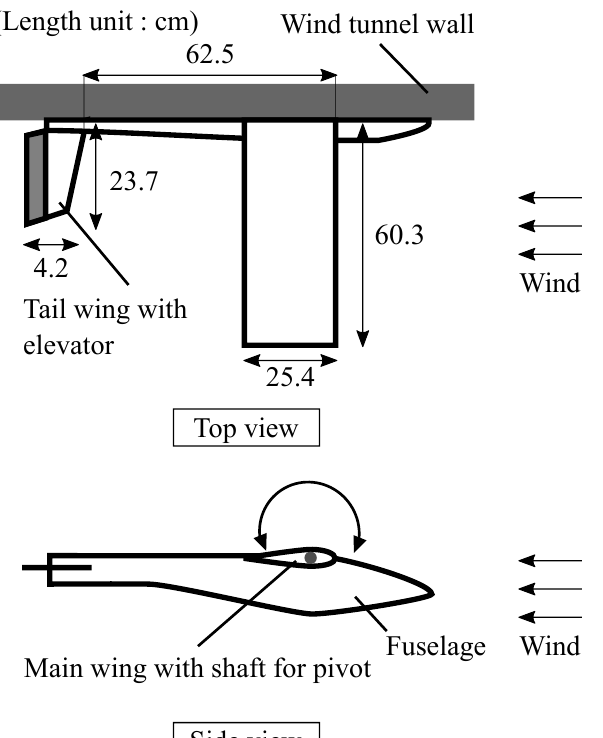
Figure 1. Schematic of the aircraft model in the wind tunnel.